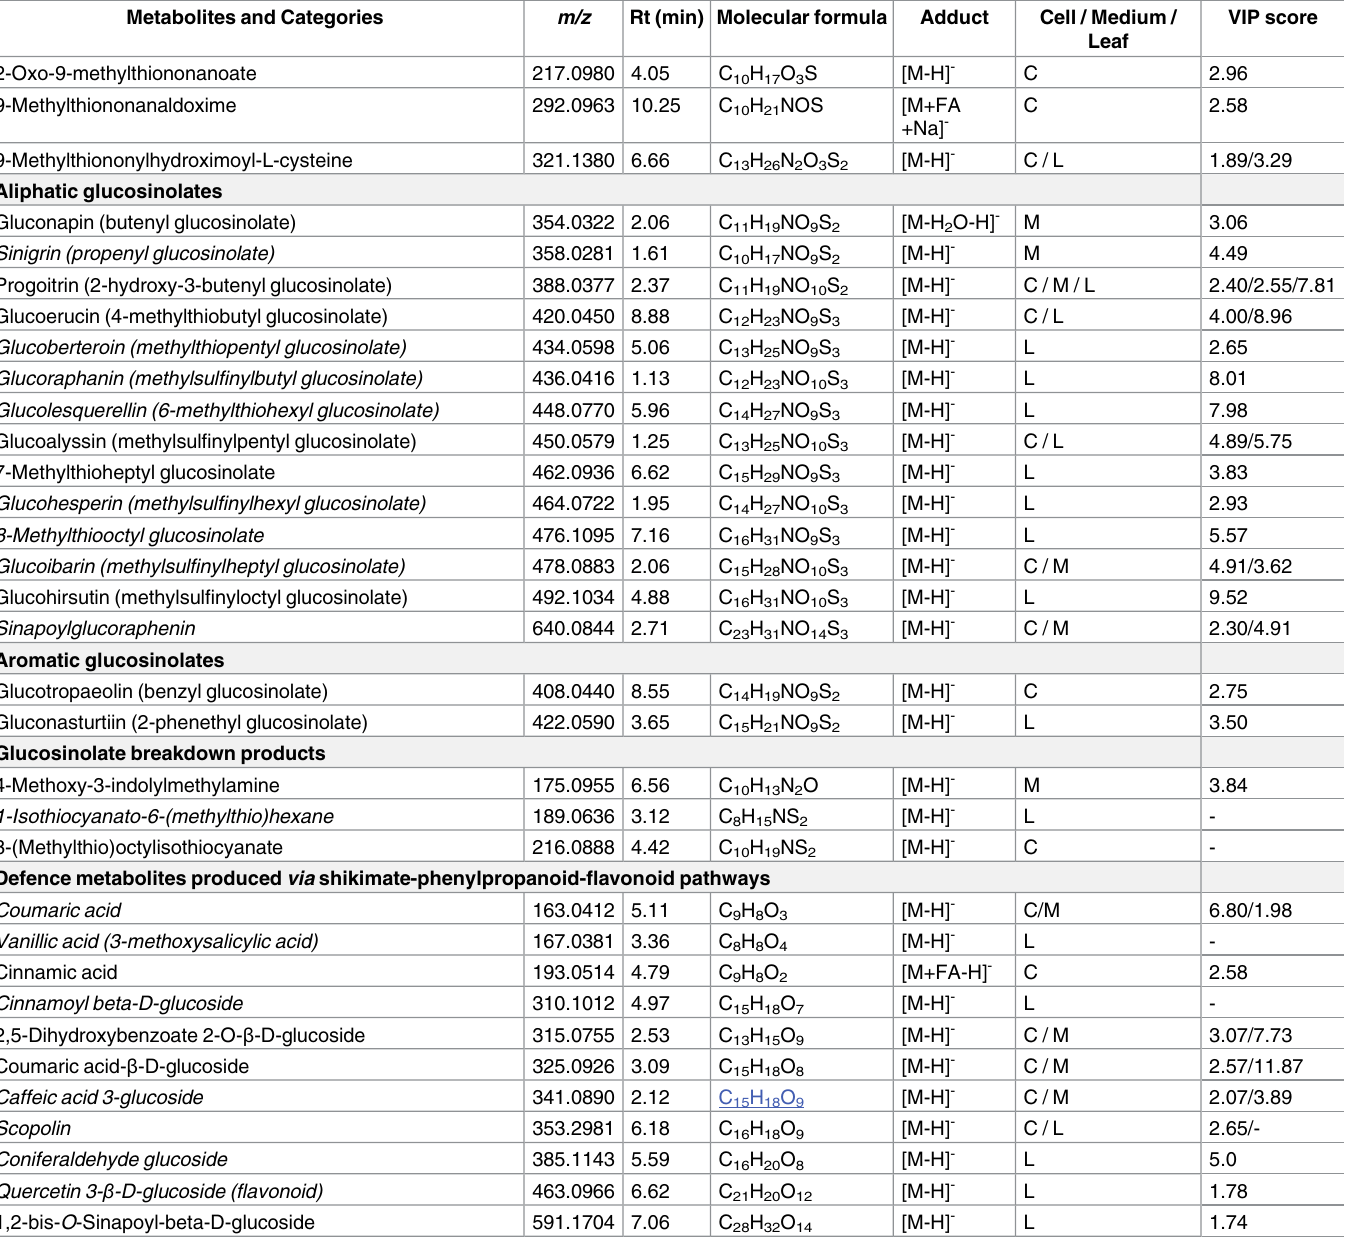
From all the PCA score plots, the LPS-induced metabolic changes in both cell cultures and leaves were evident. The S-plots and volcano plots indicated m/z ions that exhibit high magni- tude, high correlation and statistical significance. This approach was used for comparison of data from control extracts versus extracts obtained from the 8, 12 and 24 h treatments. In addi- tion, MS/MS analyses were performed to fragment specific sample ions to assist in metabolite